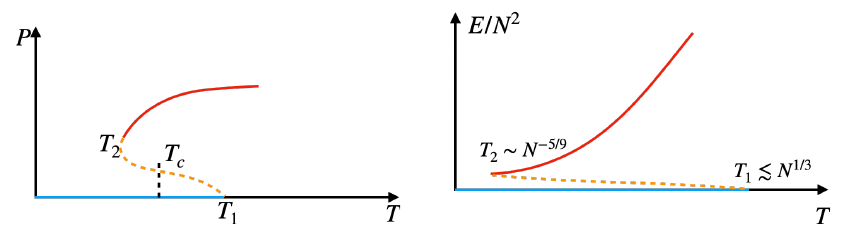
Figure 3. A cartoon of the Polyakov loop (left) and the energy (right) as functions of the temperature. The unstable phase (dashed / orange line) appears only in the microcanonical ensemble and is interpreted as a small Schwarzschild black hole along the compact M-theory circle [1] and is a partially deconfined phase [18, 19]. This phase separates the black zero-brane geometry at high energies (red) and that of the graviton gas at very low energies